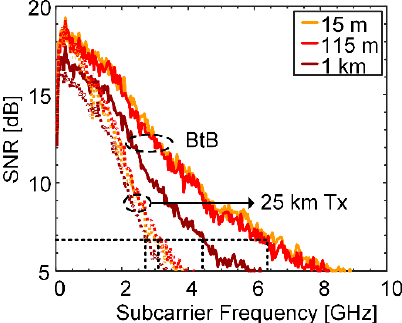
Figure 8. Measured SNR to compare the impact of transmission fiber on the performance of an RSOA-FCL: The solid and dotted lines show the measured SNR for BtB (back-to-back) and after 25 km non-zero dispersion shifted fiber (NZDSF) transmission, respectively. In both cases, the results are for 15 m, 115 m and 1 km fiber cavity lengths. The figure shows that the SNR bandwidth narrows by up to 50% after transmission over 25 km fiber. Table 2. Summary of results for the SNR performance of the RSOA-FCL with 15 m, 115 m and 1 km cavities for back-to-back (BtB) and 25 km non-zero dispersion shifted fiber (NZDSF)